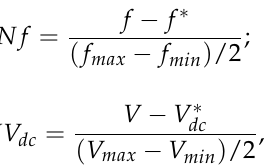
Figure 10. The principle of se tt ing droop in a hybrid microgrid.